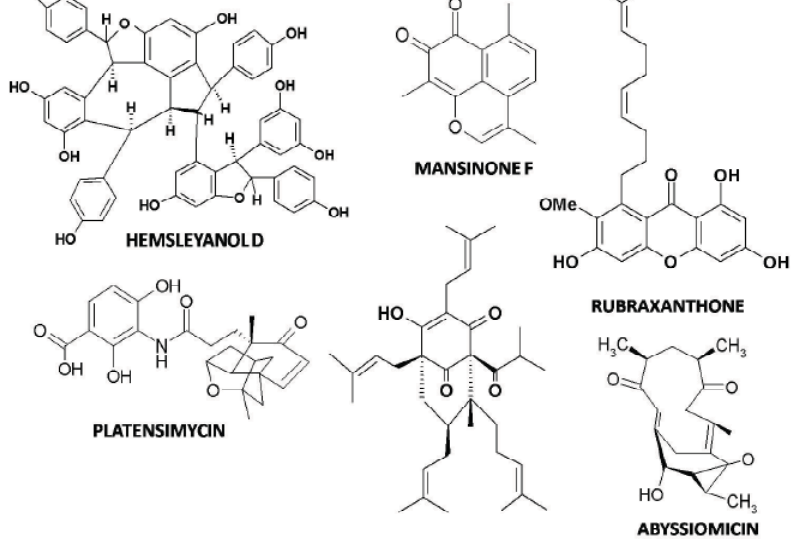
Figure 3. Promising plant and microbial natural products for use as anti- MRSA